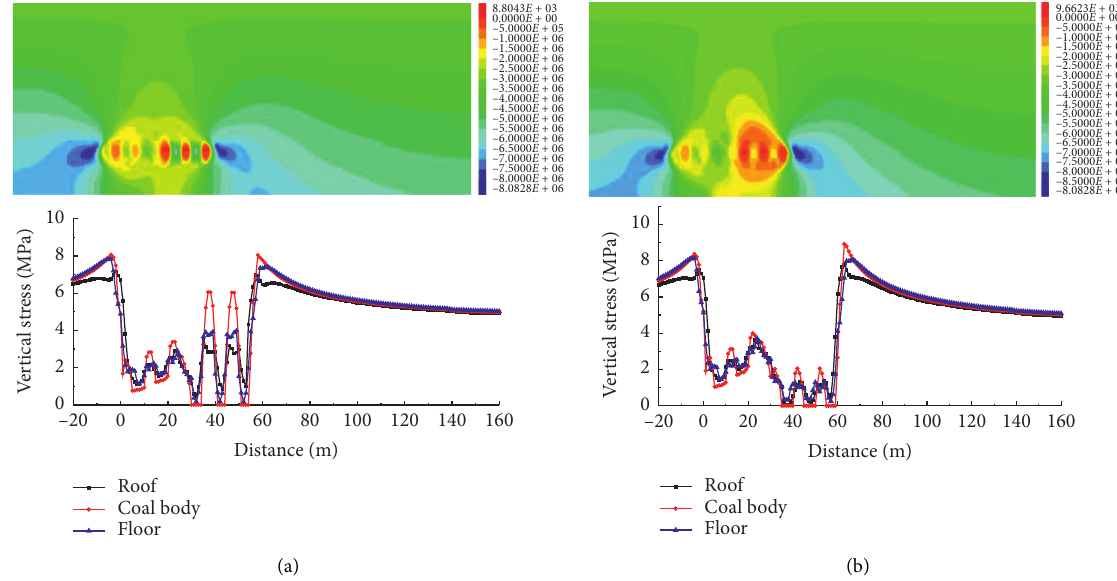
Figure 8: Filling and mining in the first group. (a) One-step mining stress contour and curve. (b) Two-step mining stress contour and